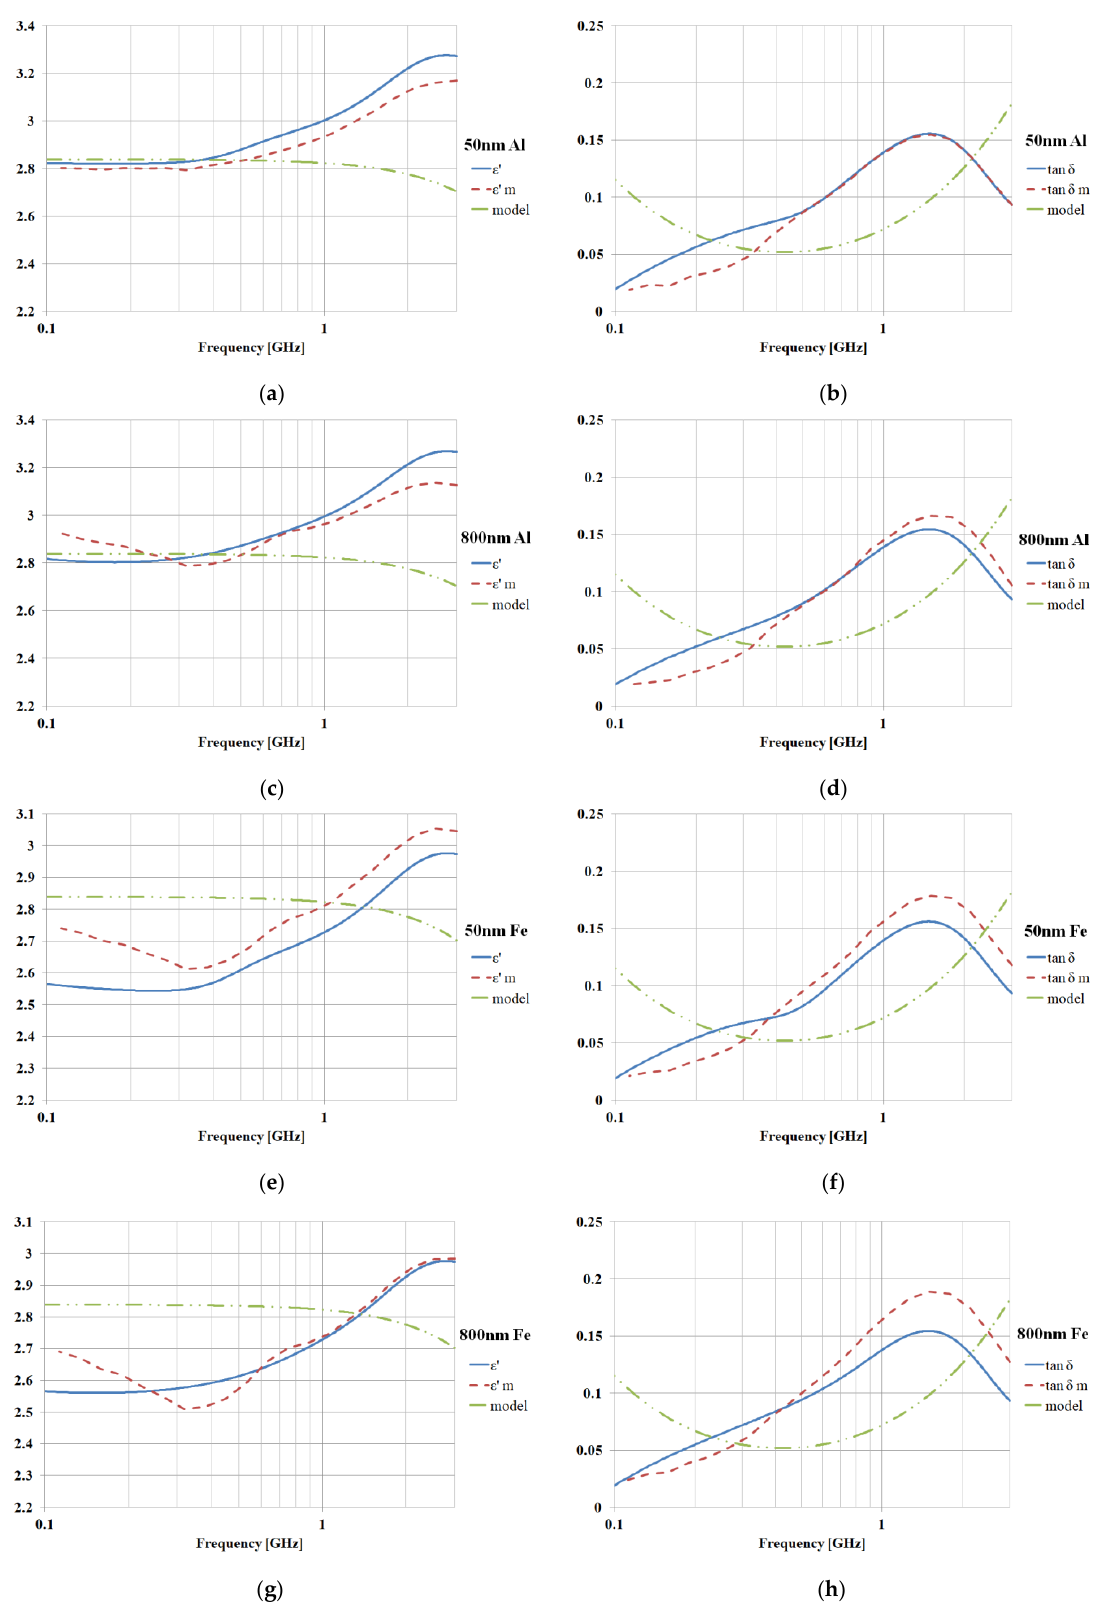
Figure 16. Dielectric properties, comparison with measurement (index m for measured parameters) and with LDPE matrix model; ( a , b ) Al 7% 50 nm, ( c , d ) Al 7% 800 nm, ( e , f ) Fe 7% 50 nm, ( g , h ) Fe 7% 800 nm. Table 2. LDPE dispersion model data list (measurements).